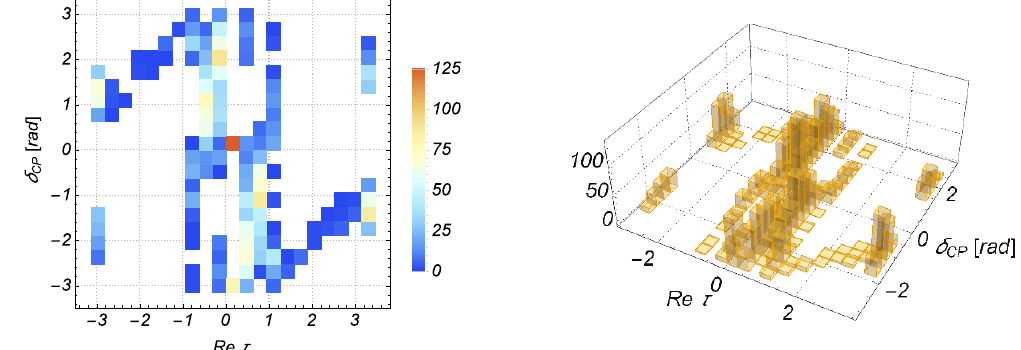
Figure 16 . Distributions of CP-violating phase δ CP vs. real part of complex structure modulus Re τ for Im τ = 1 . 8 in Pattern V.